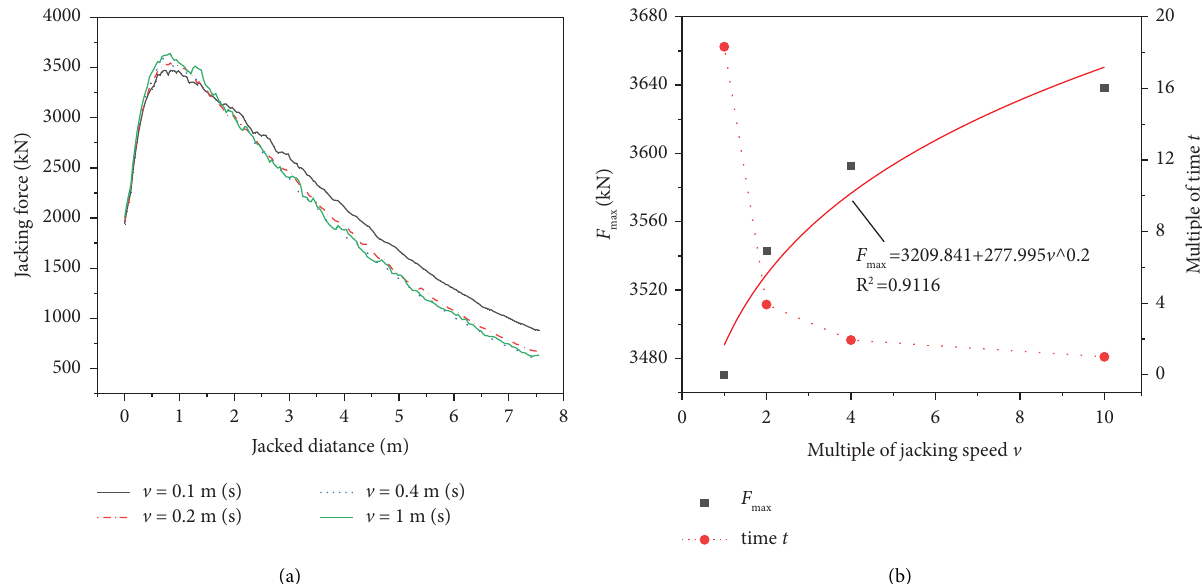
Figure 8: Infuence of jacking speed on jacking force. (a) Infuence of jacking speed on jacking force. (b) Relationship between jacking speed and maximum jacking force and software running